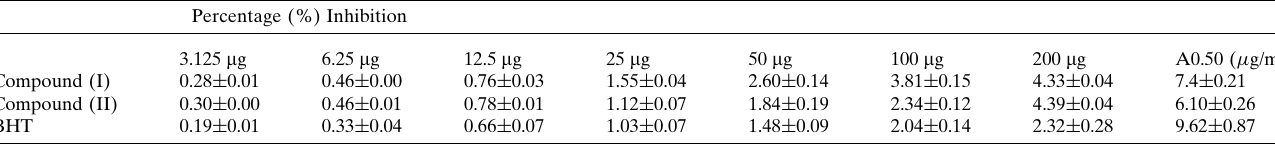
Table 4 Cupric ion reducing antioxidant capacity of compounds (I) and